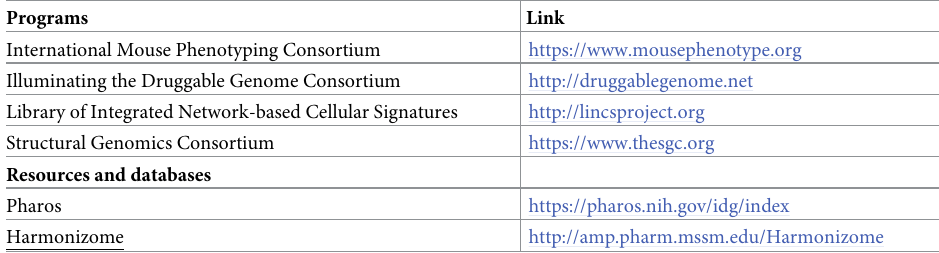
Table 1. Links to programs and resources mentioned in this